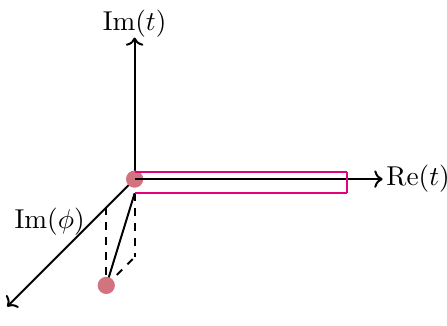
Figure 4 . SK contour with an initial state at finite temperature and chemical potential. scalar field in the bulk is dual to a scalar operator O in the boundary CFT with conformal √ dimension ∆ = 1 + 1 + M 2